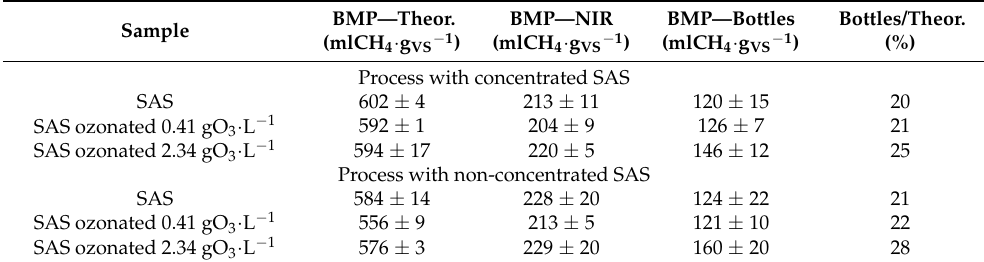
Table 3. Biochemical methane